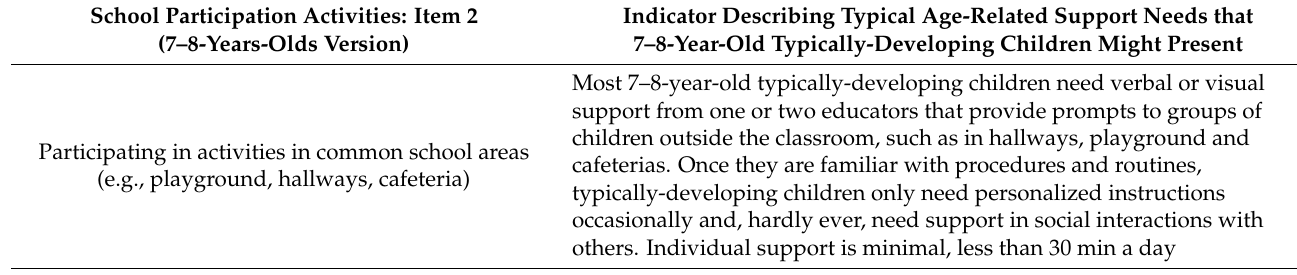
Table 2. Supports Intensity Scale—Children’s version (SIS-C) item, related indicator describing age-related typical support needs and rating scale used to show agreement with the latter (7–8 years old